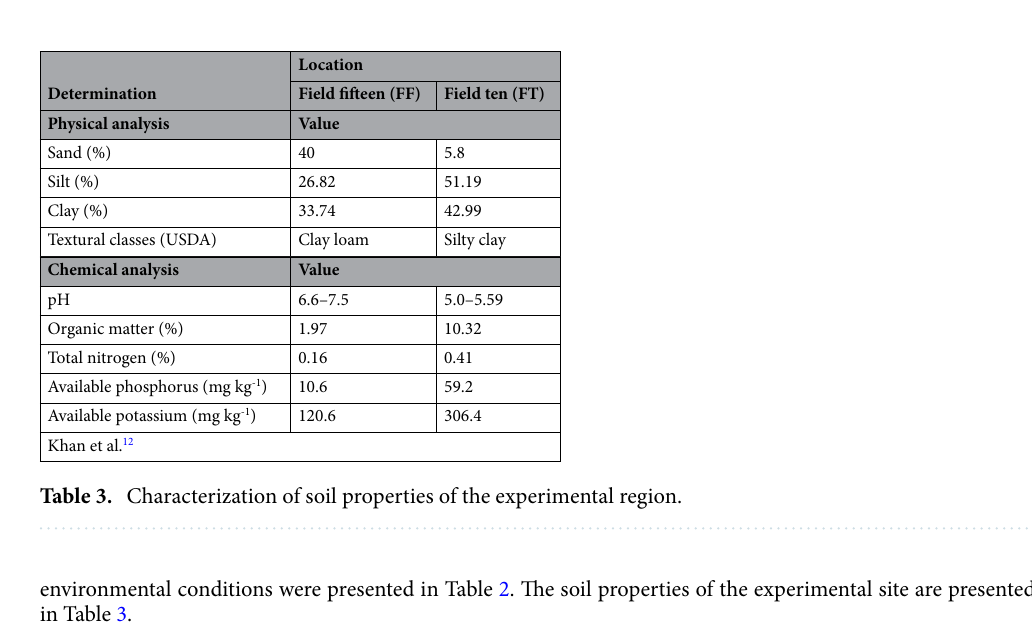
Table 2. Environmental description of the experimental site. FTM = Field ten main season; FTO = Field ten off season, FFM = Field fifteen main season; FFO = Field fifteen off season; ENV. = Environment; Main season = May- September; Off season = November–March; Av. Temp. = Average temperature; Av. Hum. = Average humidity. Sources: https:// en. clima te- data. org/ asia/ malay sia/ selan gor/ mardi- serda ng- 97161 3/# clima te- table.